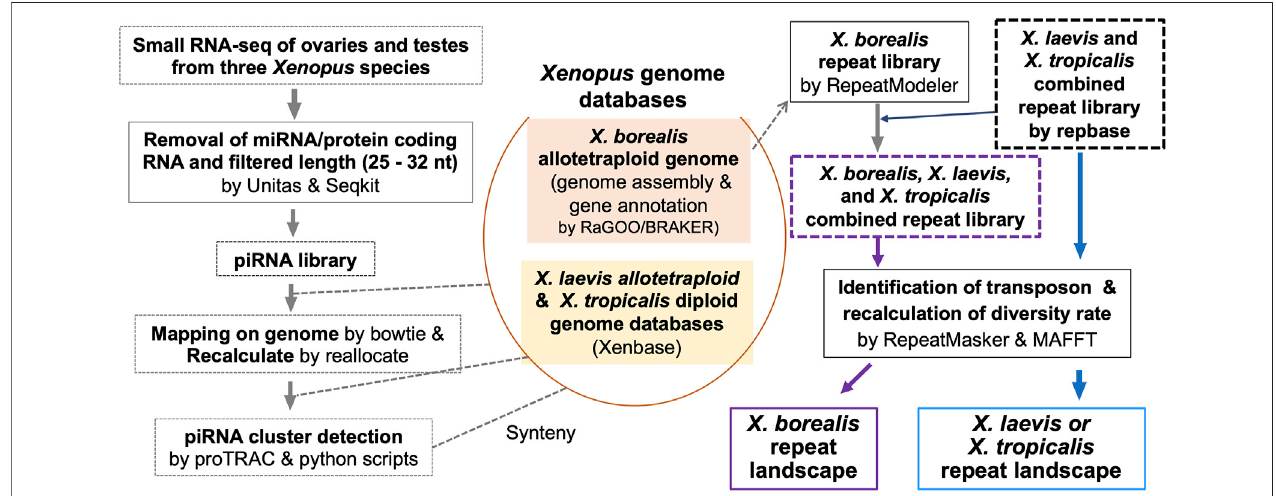
retrotransposon-, exon-, and intron-derived piRNAs from the ovaries and testes of the three species shared the two characteristics of piRNAs as the unclassi fi ed piRNAs did in Figure 2 ( Supplementary Figure S3 ). Interestingly, retrotransposon-derived piRNAs occupied higher percentages in the ovaries (37 – 41%) than in the testes (20 – 25%) in total piRNAs in all three species ( Table 1 ). In